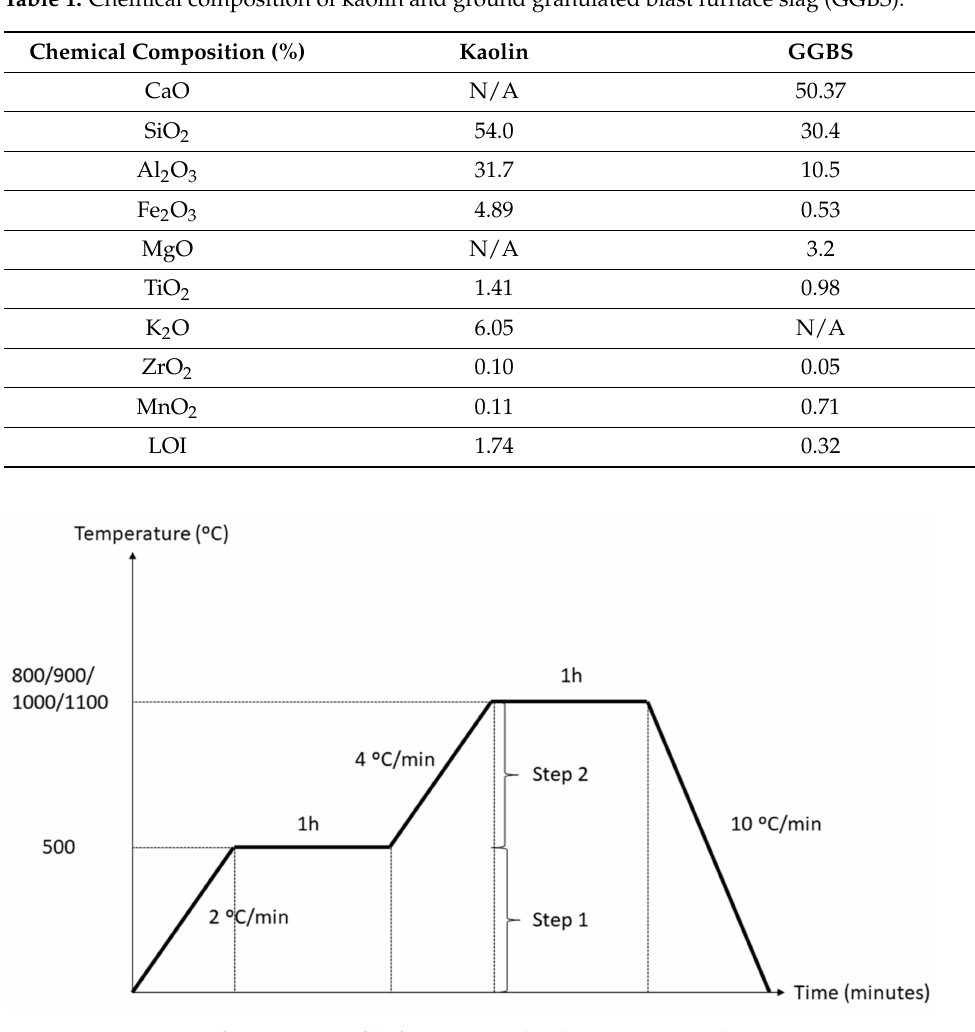
Figure 1. Two-steps of sintering profile for sintering kaolin–GGBS geopolymer. The phase composition of the raw materials and kaolin–GGBS geopolymer was deter- mined using the X-ray diffraction method (Bruker D8 Advance, USA), equipped with a copper anode (Cu Ka, λ 1.5406 Å). Prior to the analysis, the dry powder was compacted, and the analysis was recorded within a 2 θ range of 5–80 ◦ C, with a scan rate of 0.1 deg/s. Next, the data were analyzed using X’Pert HighScore Plus software. The image of the microstructure was captured using a scanning electron microscopy (ZeissSupra 35VP, Jer- man), which worked at an accelerating voltage of 5 kV. The specimens were cut into small pieces with the edges ground down to make them smooth. The samples were vacuumed for an hour and the surfaces were coated with Au–Pd for imaging purposes. The micro-X-ray absorption spectroscopy experiments were conducted at BL8 beam- line at the Synchrotron Light Research Institute (SLRI), Thailand. The X-ray absorption near edge structure (XANES) of calcium atoms in the four different sintering temperatures of sintered kaolin–GGBS geopolymers samples were measured. One sample of kaolin–GGBS geopolymer was characterized for determination of changes in calcium atoms after